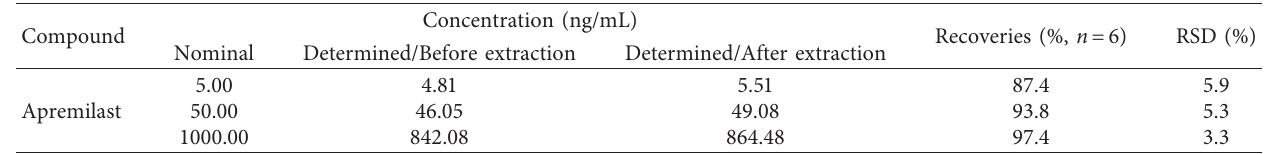
Table 2: Extraction recoveries of apremilast and clopidogrel in beagle dog plasma.